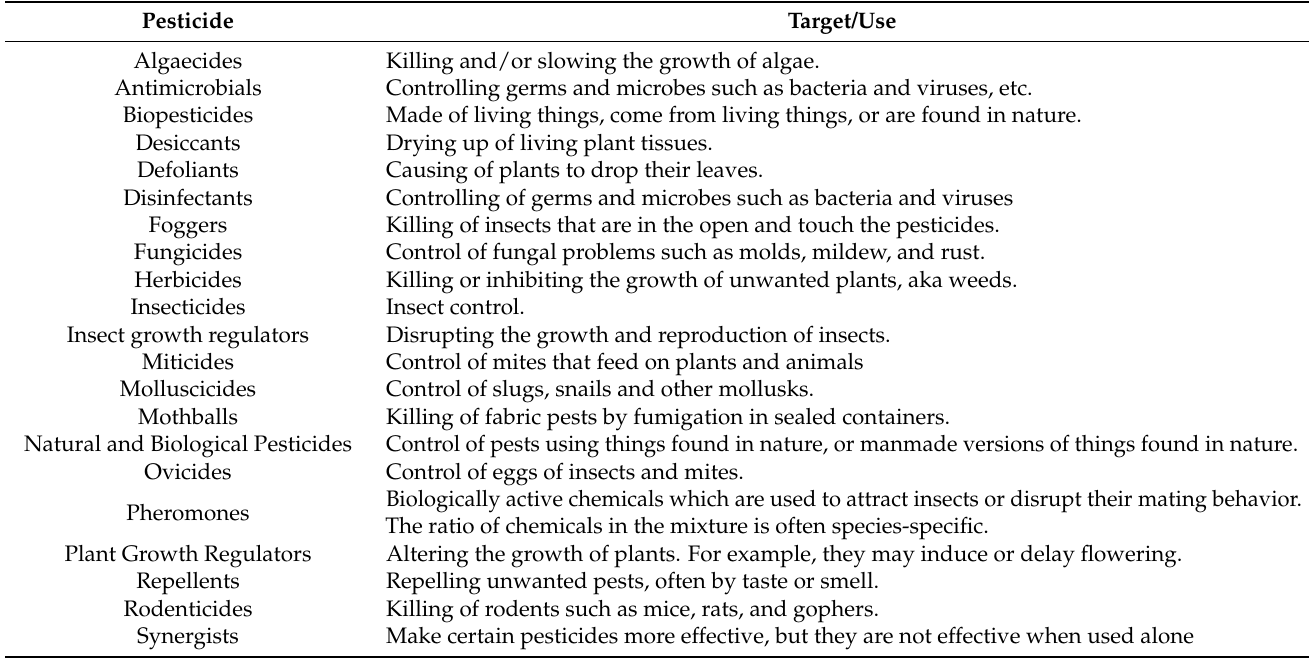
Table 1. Types of pesticides based on the National Pesticides Information Center